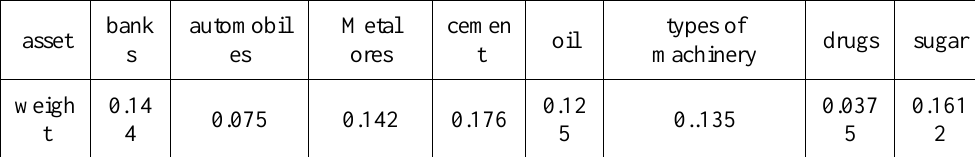
Table 5. Optimal portfolio of relative robust risk parity